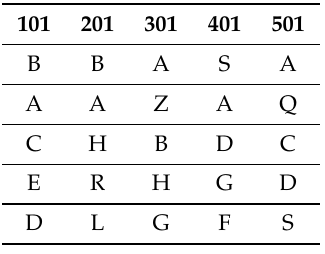
Table 2. Table of bus stops along